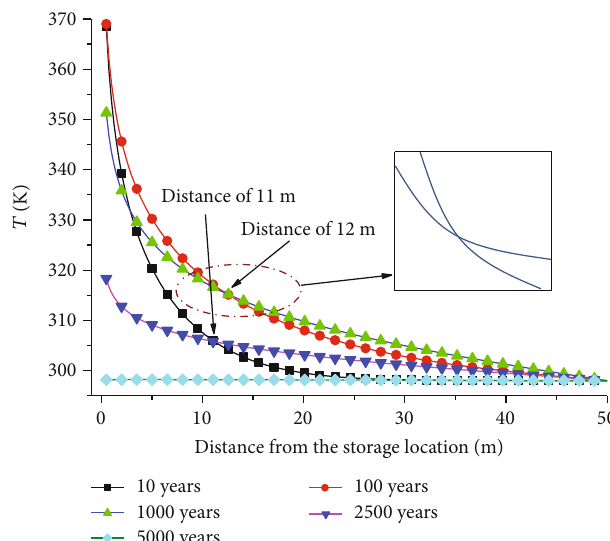
Figure 4: Evolution of reservoir temperature with the storage distance after di ff erent storage times.